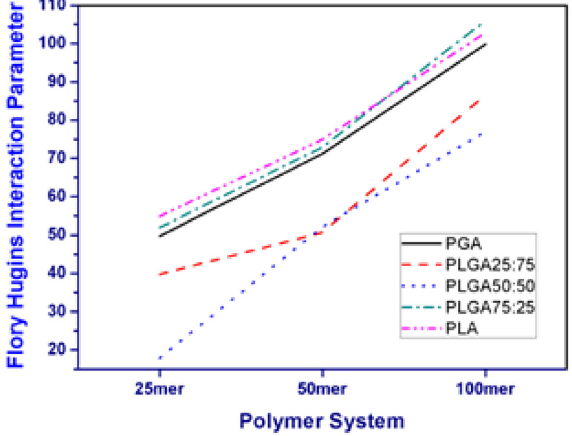
Fig. 8 Comparison of Flory – Huggins Interaction parameter ( χ ) cal- culated for all the polymer – coumarin-6